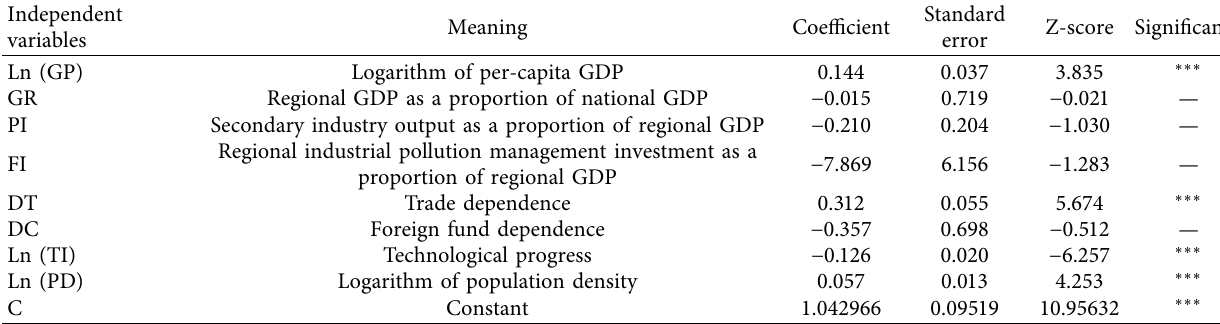
Table 5: Tobit regression